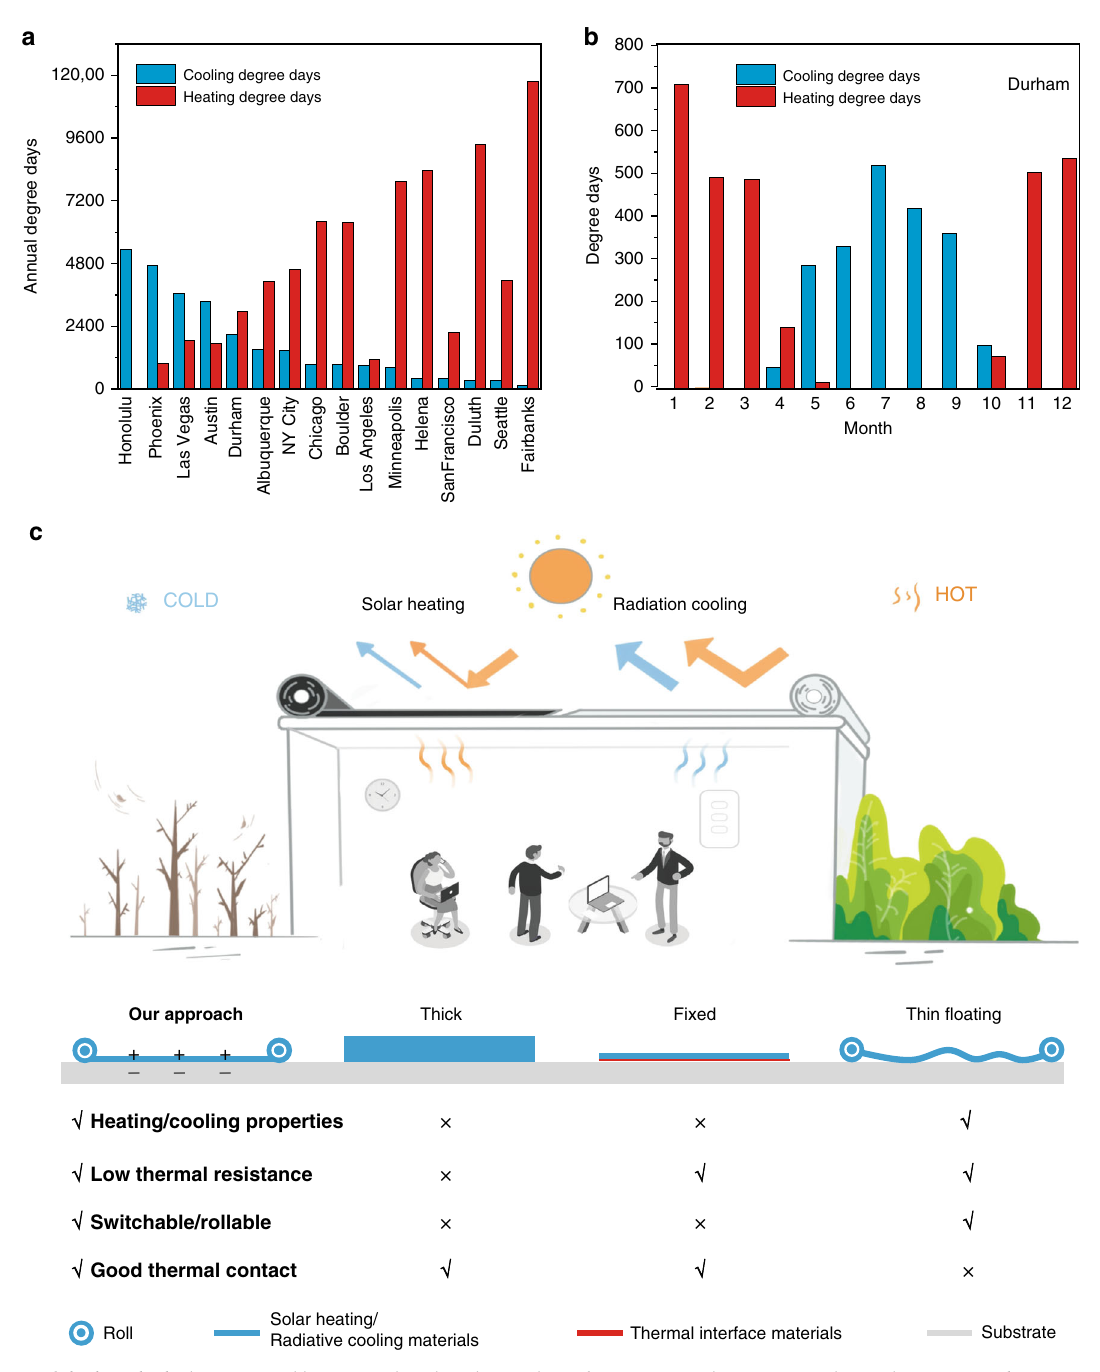
Fig. 1 Concept of dual-mode device. a Annual heating and cooling degree days of 16 U.S. cities that represent the 16 climate zones. b Heating and cooling degree days over 12 months in Durham, NC, USA. c Schematic of the dual-mode device at heating (left) and cooling (right) mode. The switchable building envelope can utilize both renewable heating and cooling sources. We identify the four criteria of the dual-mode device: heating/cooling optical properties, thermal resistance, rollability, and thermal carbon black reference on the plate to obtain the temperature applied voltage., and the corresponding temperature difference is difference between sample and substrate to calculate the contact suppressed to about 0.4 °C (Supplementary Fig. 2). Note that even resistance (more details can be found in “ Methods ” ). As shown in the voltage is high, the current is only about 0.07 mA, which is a Fig. 2c, the average thermal contact conductance signi fi cantly safe current for the human body 33 . Moreover, as shown in Fig. 2d, the average thermal contact resistance between PI fi lm increased as the applied voltage increased. The Maxwell pressure and substrate is almost unchanged after removing the voltage increases not only the macroscopic contact area (Supplementary source for 3 days (Ambient condition: 20 °C, 40% humidity) due Fig. 1) but also the microscopic area 32 , both of which result in the to the high electrical resistivity and hydrophobicity of PI. It can be reduction of overall thermal contact resistance. The average expected that this static electricity may not last for several thermal contact conductance can reach 9.5 × 10 2 W/m 2 K at 2 kV